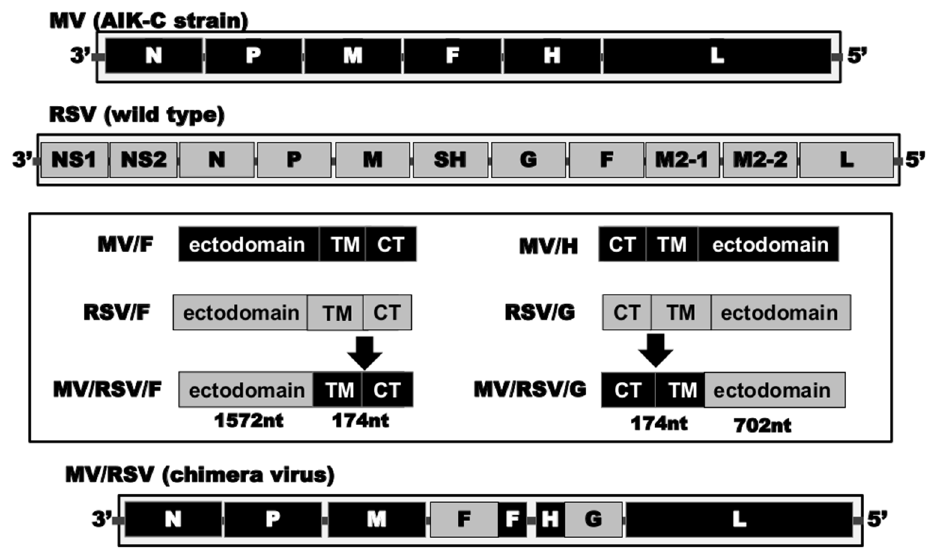
Figure 1. Construction strategy. Gene of the measles virus is shown in black and that of RSV in gray. The ectodomains of measles F and HA protein genomes were replaced with those of RSV F and G protein genomes. They were fused to the respective TM–CT region of the measles virus. The chimeric infectious cDNA (MV/RSV) was constructed and details are in Supplemental Figures 1 and 2.